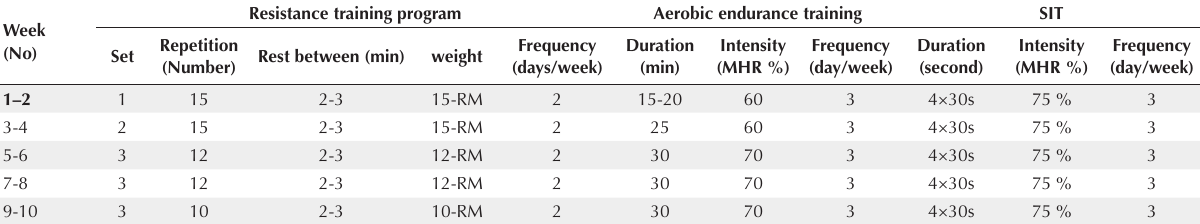
Resistance training program Aerobic endurance